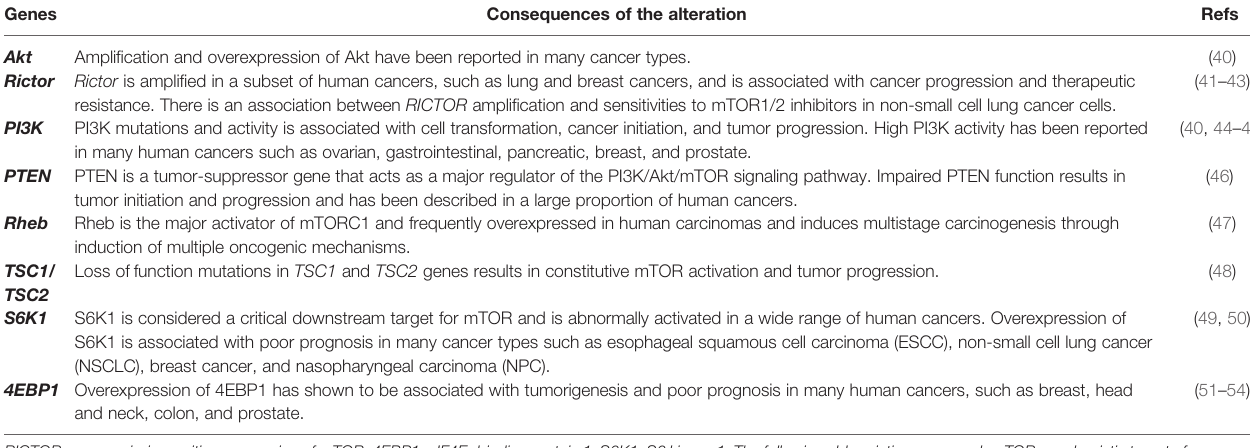
TABLE 1 | The role of PI3K/Akt/mTOR signaling pathway components in cancer. Genes Consequences of the